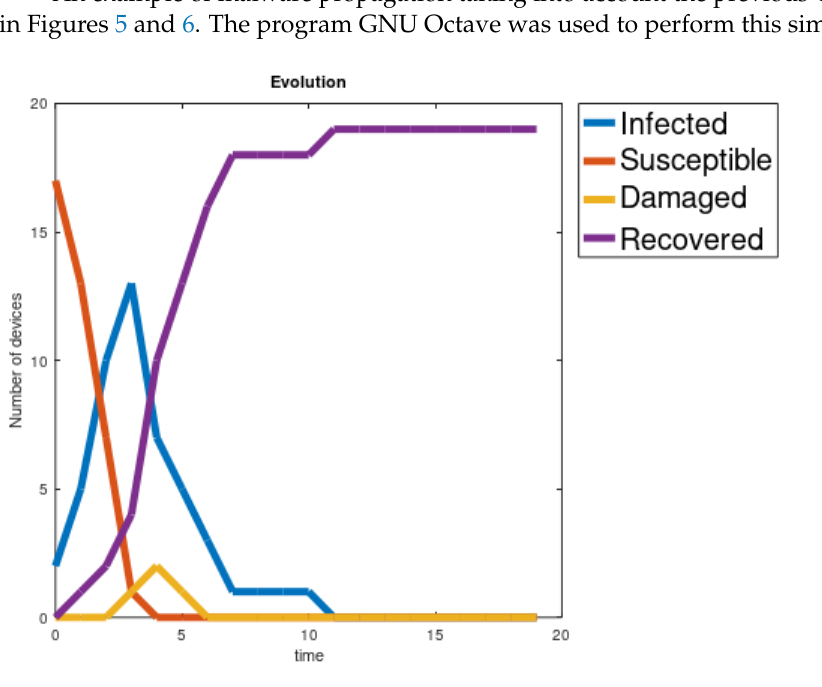
Figure 5. Malware propagation with damaged